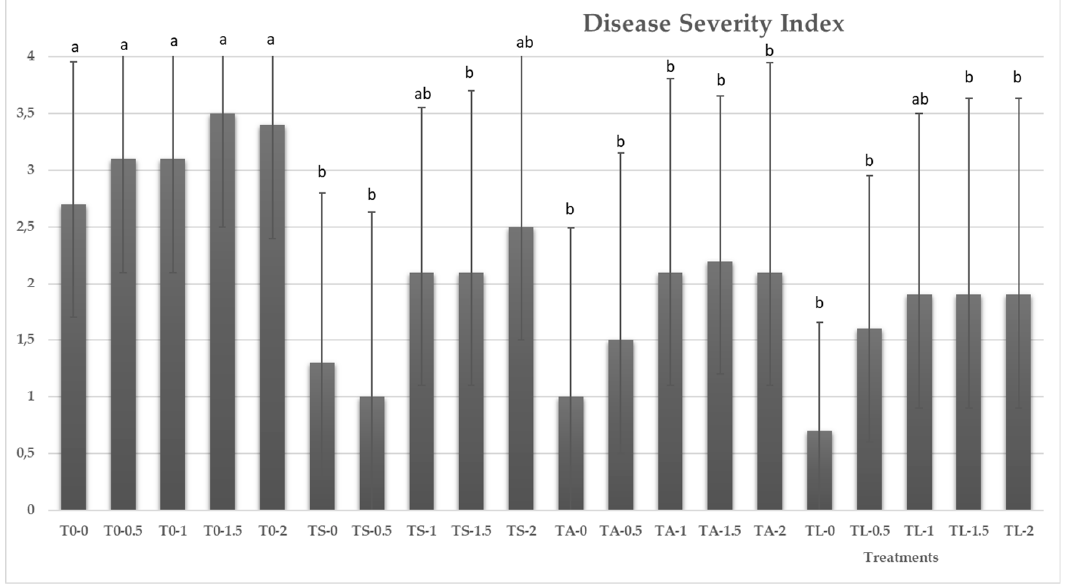
Figure 4. Disease incidence of P. ultimum in melon plants was rated 30 days after inoculation based on a 0–4 scale: where 0 = no visible disease symptoms and 4 = plant dead. Mean standard deviation is expressed in error bar ( n = 10). a, b, c Means with the same letter are not significantly different (LSD) according to ANOVA test ( p < 0.05).